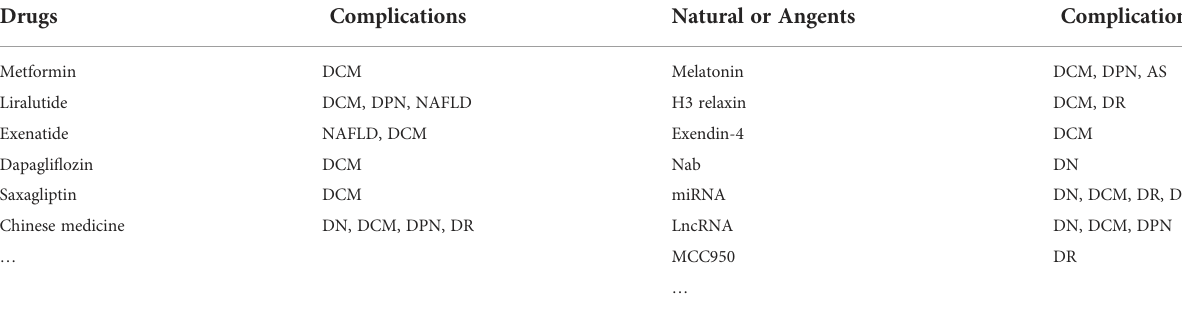
TABLE 1 Potential drugs and agents that inhibit NLRP3 in fl ammasome signaling